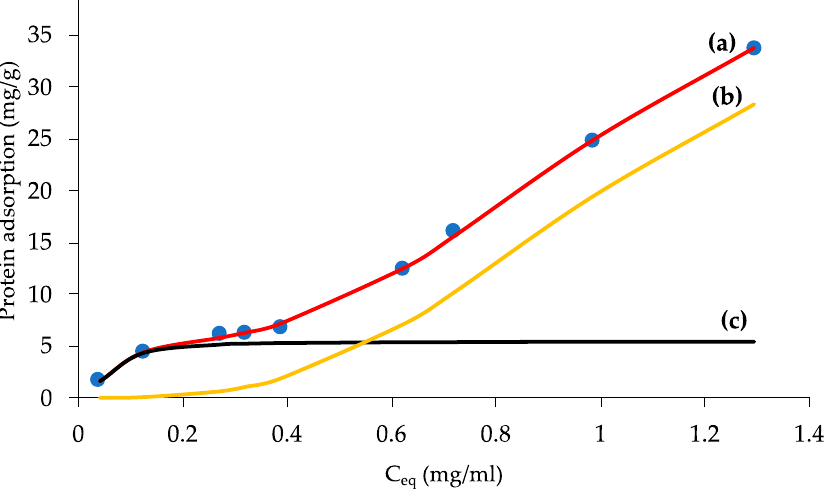
Figure 6. Albumin adsorption isotherms with fitted elements. (a) left-side and (b) right-side, of Equation (4); (c) fit of the experimental points (labelled as blue dots).